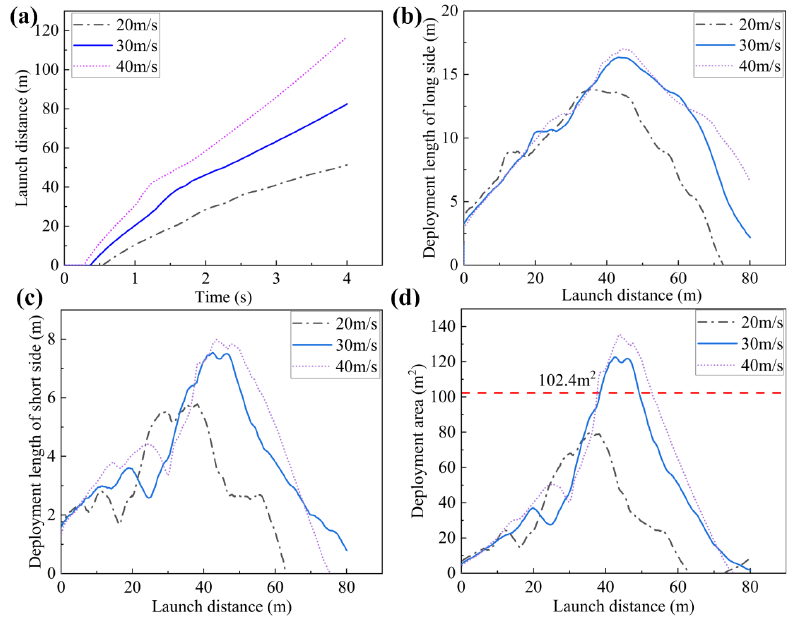
Figure 19. Deployment performance with different launch speed values. ( a ) Launch distance. ( b ) Deployment length of long side. ( c ) Deployment length of short side. ( d ) Deployment area. Table 5. Deployment parameters with different launch speeds.